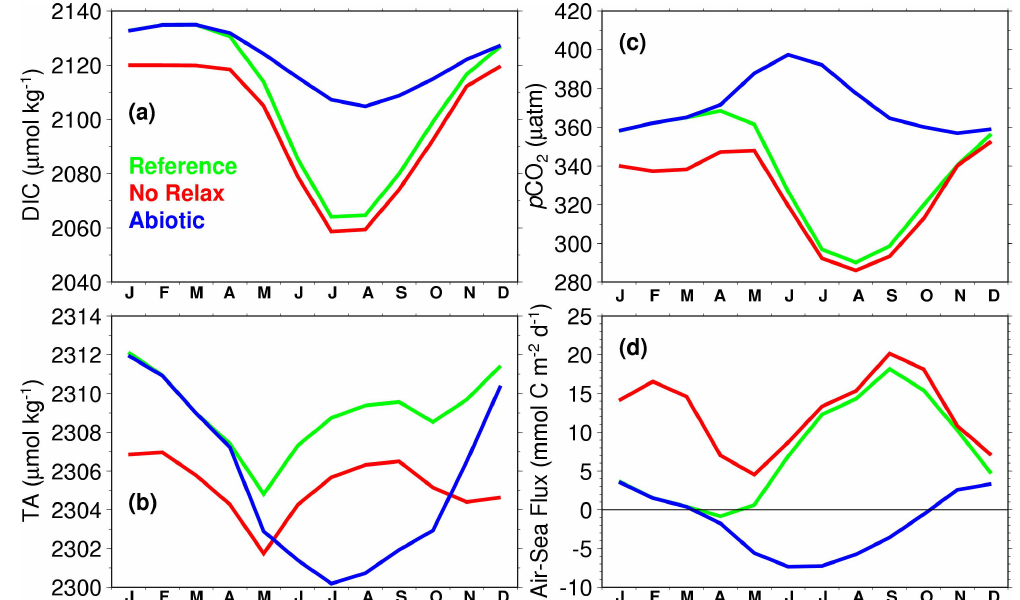
Fig. 7a. Climatologic seasonal variability of surface ocean DIC (a) , TA (b) , p CO 2 , and air-sea CO 2 flux for three different model runs: ref- erence (Experiment A, green), no DIC and TA relaxation and without bottom DIC trend (Experiment B, red), and abiotic ocean (Experiment C,